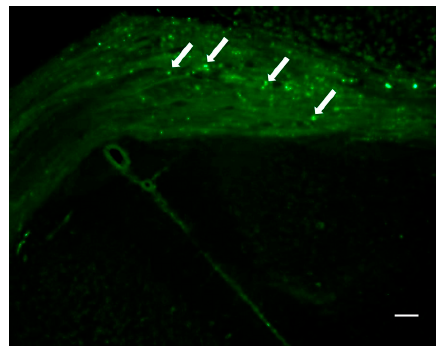
Figure 9. Image of G4-90/10 dendrimer migrating across the hemispheres through the corpus callosum (arrow) 1-week post-intracranial transplantation into the striatum. Image was taken at 10× magnification using Zeiss Observer inverted Microscope (Zeiss, Oberkochen, Germany) Scale bar: 100 μ m.